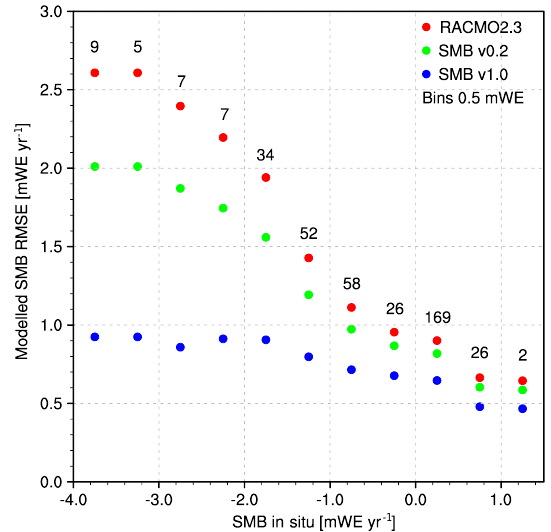
Figure 14. Annual mean modelled SMB RMSE (model vs. ob- servations) of the 11km SMB field in RACMO2.3 (red dots), the downscaled SMB data set v0.2 (green dots) and v1.0 (blue dots) as a function of observed SMB (395 observations). Modelled SMB is grouped in 0.5mWEyr − 1 bins except for the first bin, which ranges from − 6.00 to − 3.75mWEyr − 1 . Numbers indicate the number of observations used in each